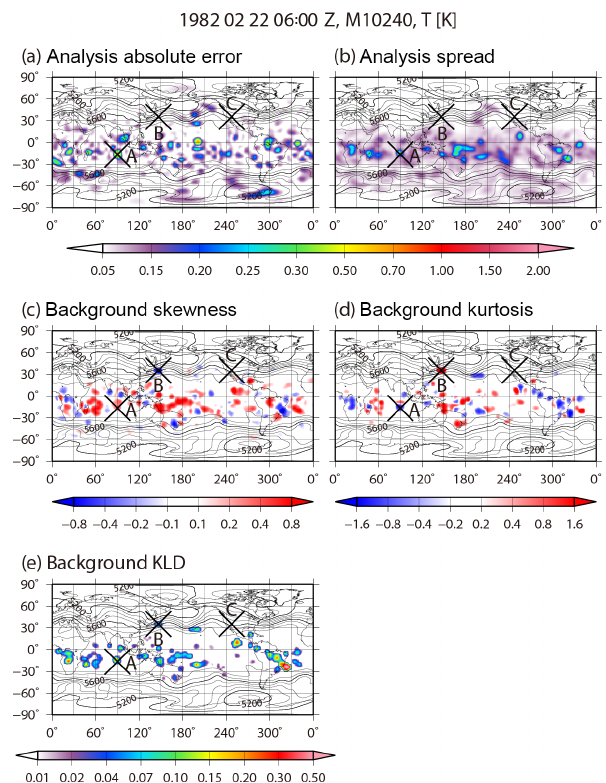
Figure 4. Spatial distributions of (a) analysis absolute error, (b) analysis ensemble spread, (c) background skewness, (d) back- ground kurtosis, and (e) background KL divergence for temperature at the fourth model level ( ∼ 500hPa) at 06:00UTC on 22 February. Contours indicate geopotential height of the ensemble mean at the 500hPa level.